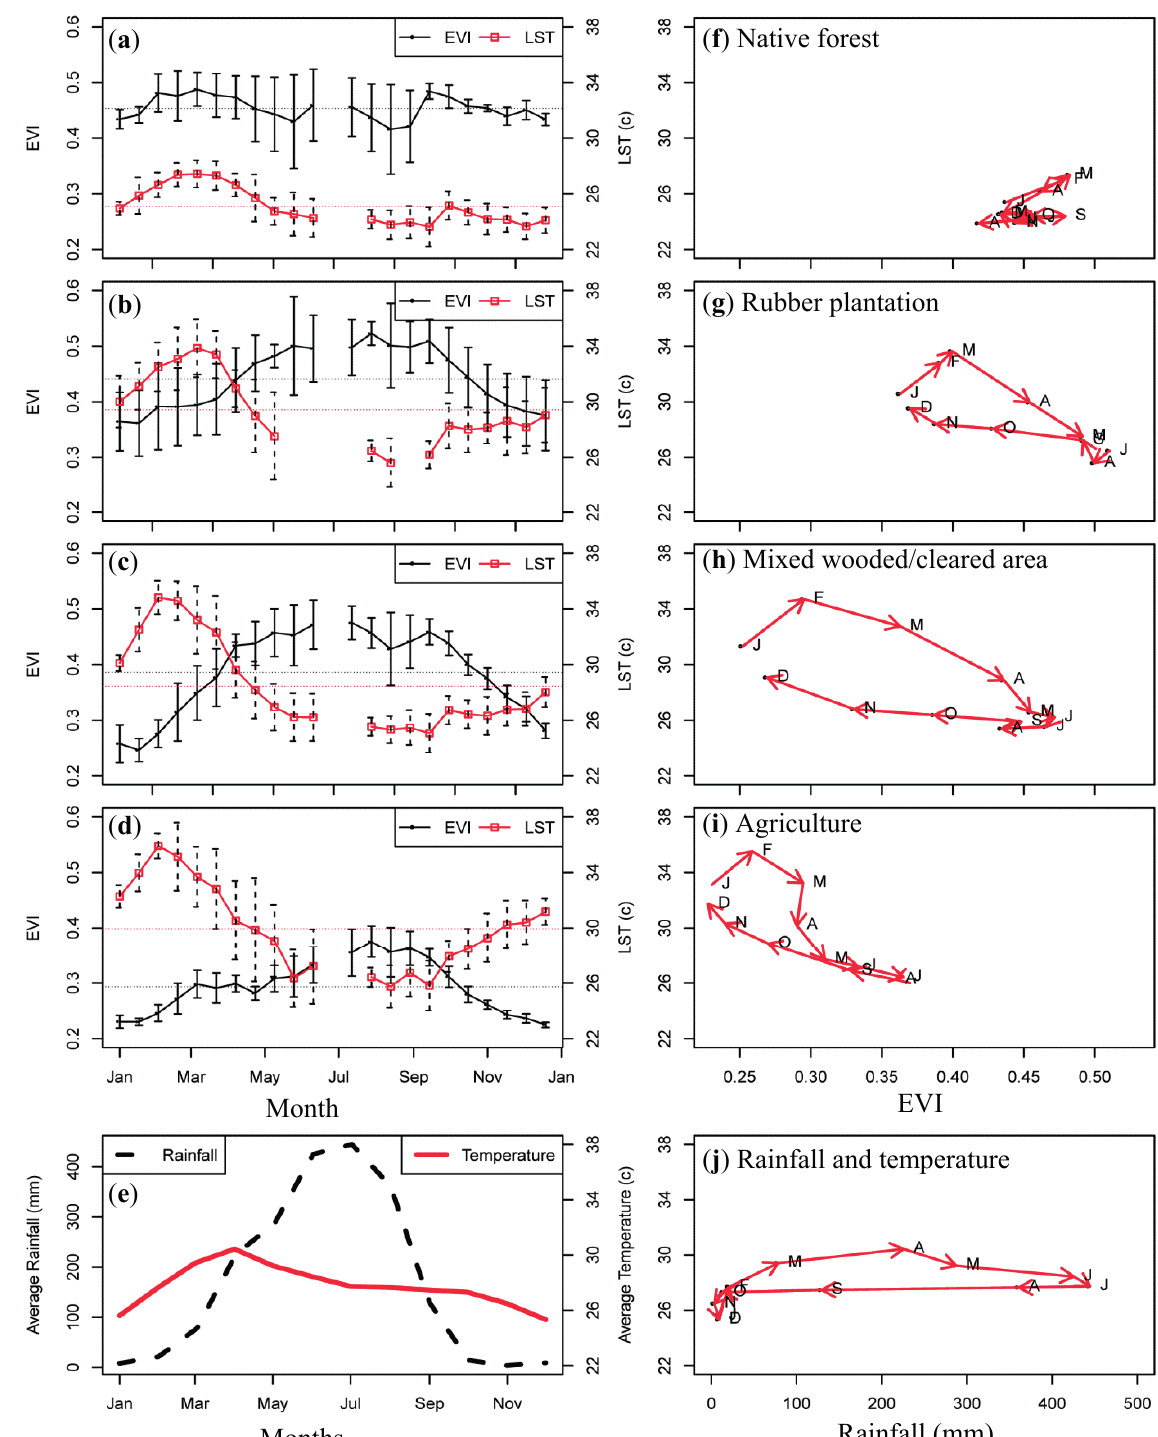
Figure 4. The average temporal responses of land surface temperature (LST) and enhanced vegetation index (EVI) from 2006–2012 in four different forest covers: ( a ) native forest, ( b ) rubber plantation, ( c ) mixed wooded/cleared area, ( d ) agriculture (the red line is LST in Celsius and its standard deviations (SD), while the black line is EVI and its SD), and ( e ) average temporal responses of rainfall and temperature, ( f – i ) are hysteresis patterns of LST/EVI for these land covers, ( j ) seasonal transitions of average rainfall and